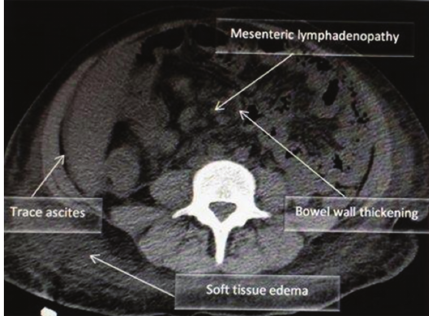
Figure 1: Abdominal CT scan which showed mesenteric lym- phadenopathy, bowel wall thickening, trace ascites, and soft tissue edema.